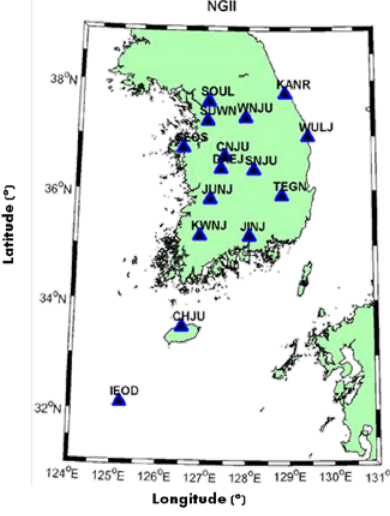
Figure 3. Location of NGII GPS CORS Network.